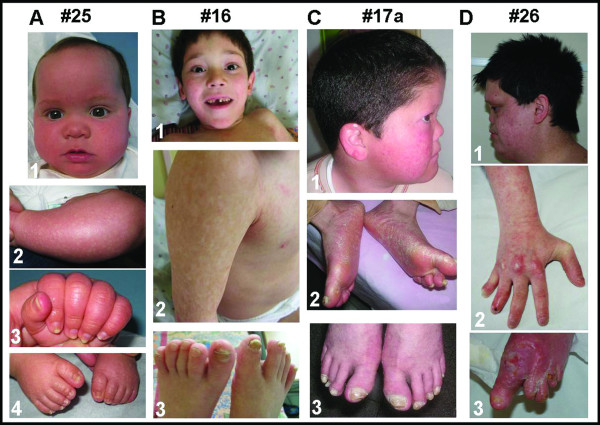
Clinical findings of four differently aged PN patients. Panel A refers to the US patient (#25); B, C and D to the Turkish patients #16, #17a and #26, respectively. Patient #25, the youngest in our cohort shows an erythroderma characterized by background erythema and islands of relative sparing on face and legs (A1, A2) and distal onycholysis of fingers and toes (A3, A4). Patient #16 face: poikiloderma and carious teeth are well apparent (B1). Poikiloderma is also visible on the trunk and arm (B2). Pachyonychia of the toes is shown (B3). Facial view of patients #17a and #26 demonstrating prominent forehead, saddle nose and long philtrum (C1, D1); poikiloderma is evident on the face and on the ear helix too (C1) and forearm (D2). Plantar hyperkeratosis (C2) and nail thickening (C3) can be seen. Severe malformation of hands and feet with unhealing ulcers and marked nail dystrophy (D2, D3).